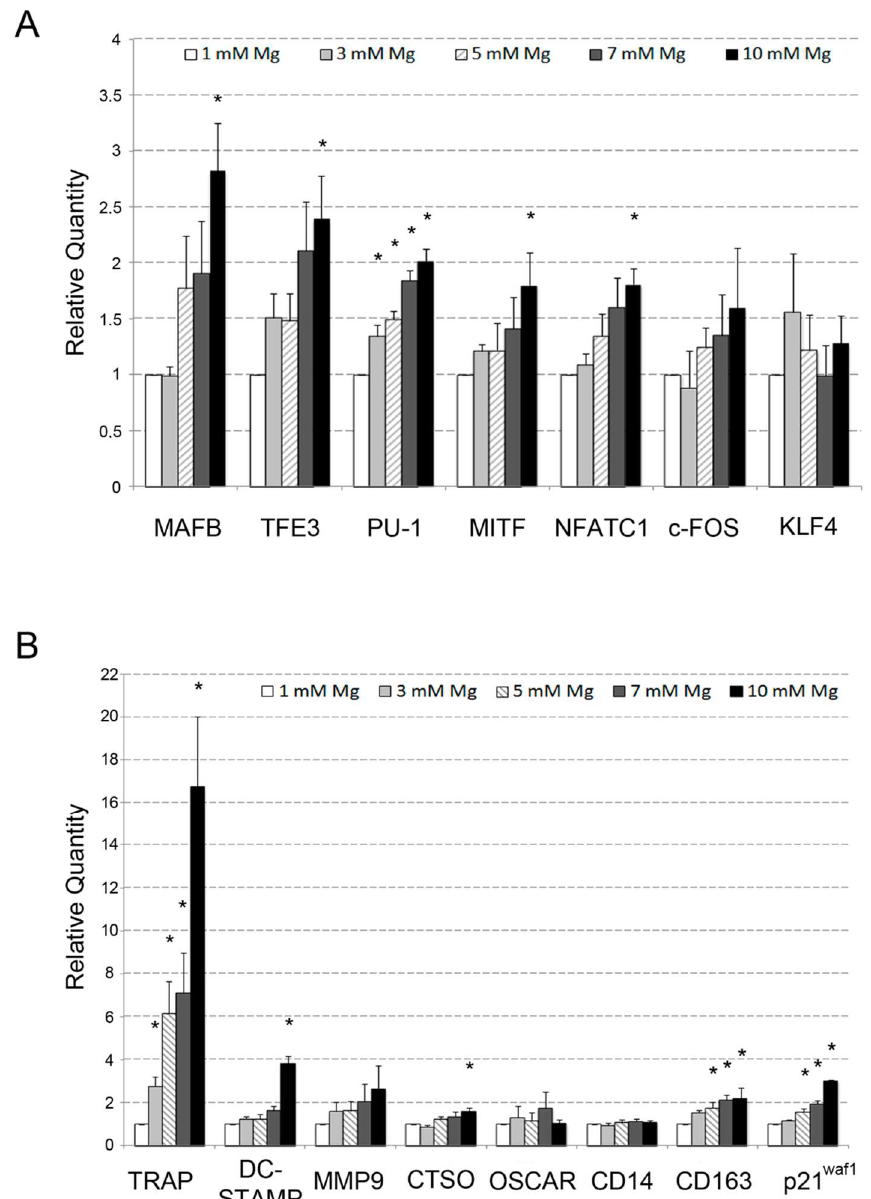
Figure 1. Effects of supra-physiological Mg concentrations on U937 cell-derived osteoclasts. U937 cells were differentiated to osteoclasts upon treatment with phorbol 12-myristate 13-acetate (PMA) and vitamin D 3 (VD3) for five days and simultaneously exposed to scalar concentrations of Mg ranging from 1 to 10 mM. The messenger RNA (mRNA) expression of transcription factors ( A ) and differentiation markers ( B ), both related to osteoclast differentiation, was then assessed using QRT-PCR. The results obtained are represented as histograms indicating analyzed genes on the x -axis and relative quantity of mRNA variations on the y -axis. Data are reported as means ± standard error of the mean (SEM) values deriving from a triplicate experiment. Asterisks indicate statistically significant results. p < 0.05.